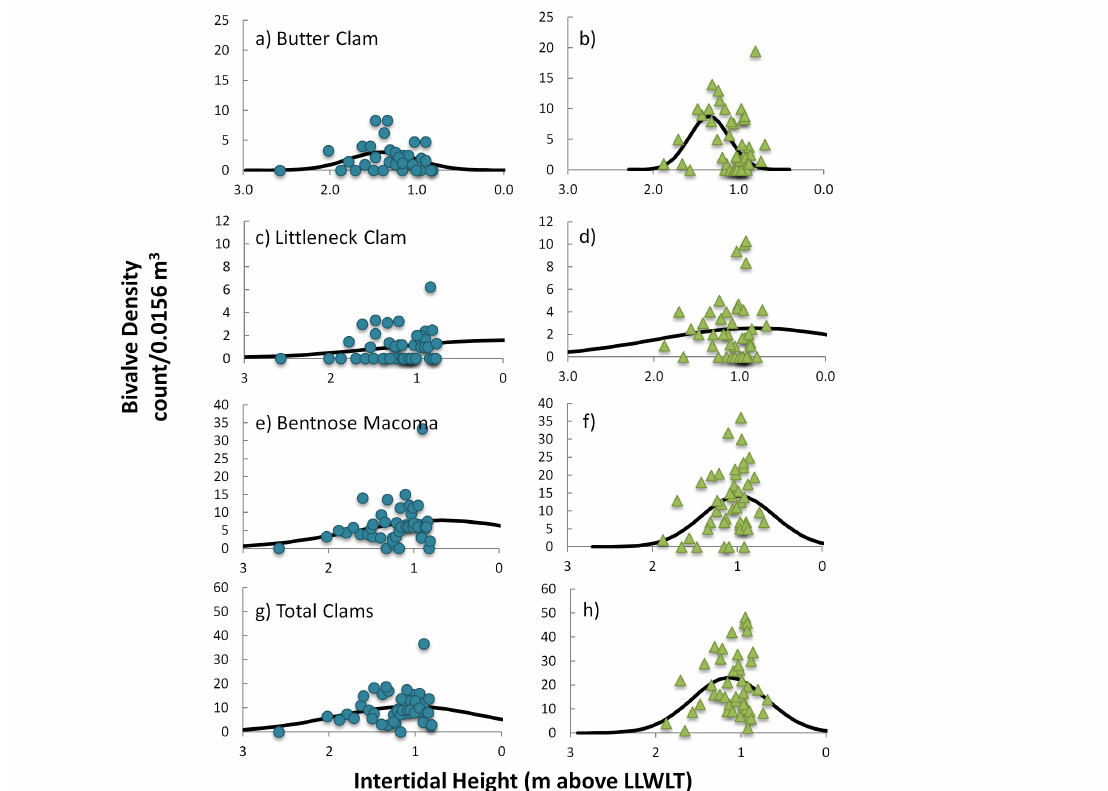
Figure A2.1. Actual (symbols) and predicted (line) density of butter clams (a, b), littleneck clams (c, d), Bentnose macoma (e, f) and total clams (g, h) as a function of intertidal height (m above LLWLT) in clam gardens (green) and non-walled beaches (blue). Note variation in y-axes range among different bivalve